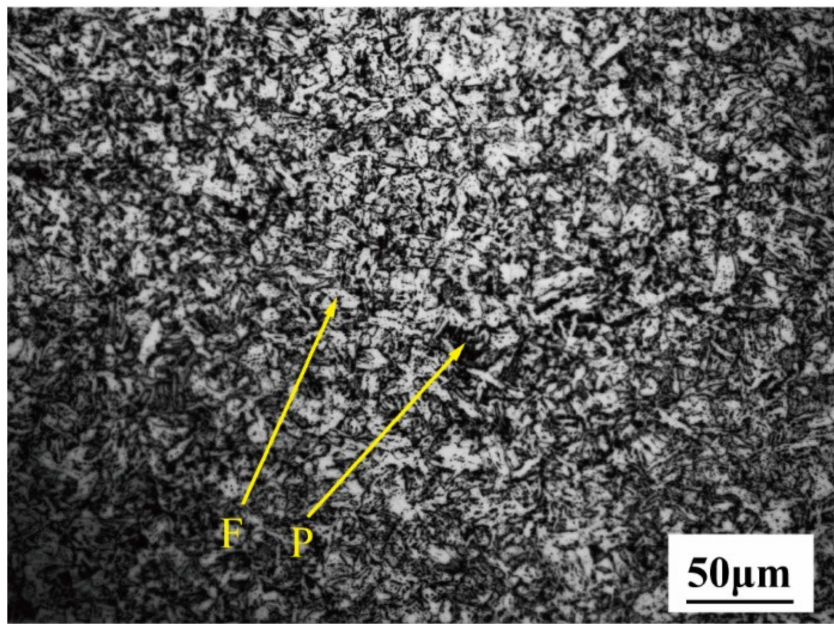
Figure 1. Microstructure of BR1500HS high-strength steel.